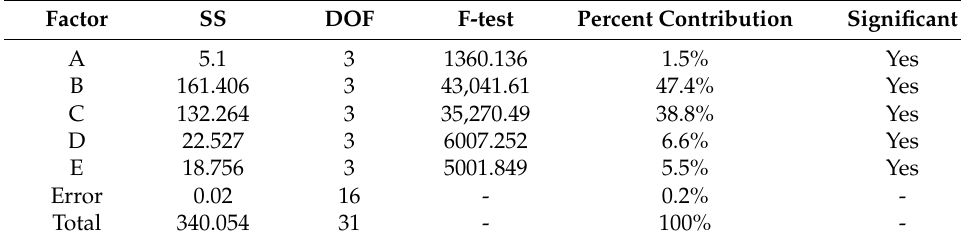
Figure 11. Surface roughness factor response diagram. Table 8. Analysis of variance in surface